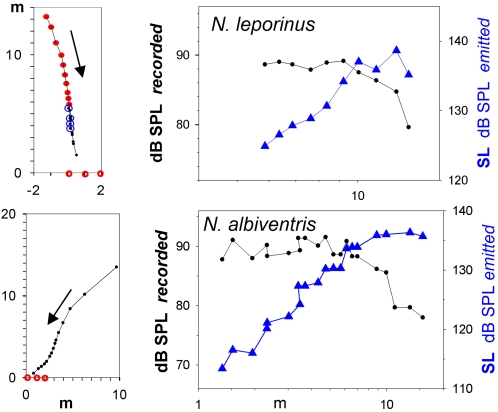
Measured call intensity and source level as bats approach the array.Two individual approach flights of N. leporinus (upper panel) and N. albiventris (lower panel). The flight paths (left panels) with arrows indicating the flight directions are shown as seen from above as the bats approached the three microphones (red circles on the x-axis). For N. leporinus, blue circles show positions based on photos. Source levels were estimated for the search calls marked by red in the flight path. The last calls in this recording were approach/terminal calls of a pursuit for which source level was not estimated. For N. albiventris, all calls were search calls and source levels were estimated for the whole sequence. The right panels show the recorded sound level and estimated source level (SL) as a function of distance between bat and microphone. At long distances the source level is constant, while at short distances the bat reduces the source level, such that the recorded level is constant as the bat gets closer.